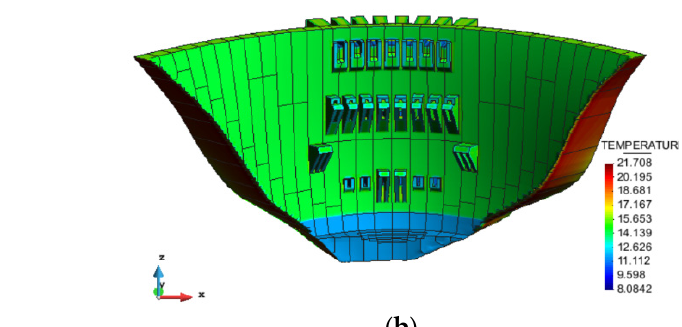
Figure 16. Cloud map of quasi-stable temperature field distribution of the dam in April (unit: °C). ( a ) Upstream face; ( b ) Downstream surface.